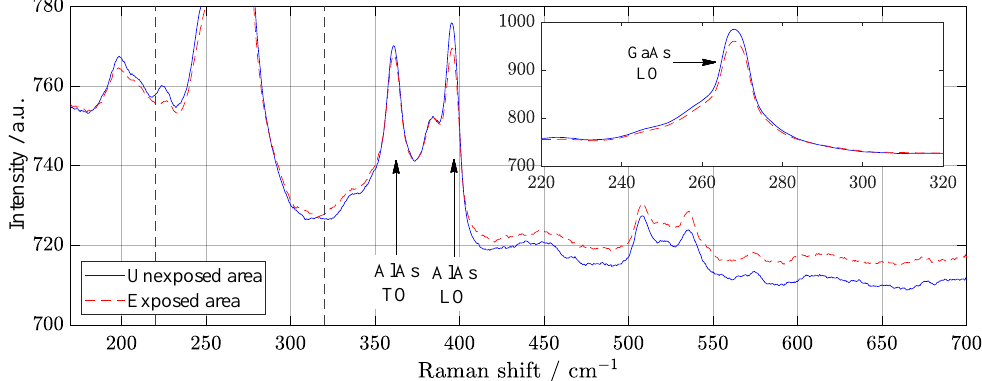
Figure 3. Raman spectroscopy from specimen processed by supercontinuum laser irradiation. Due to the height of the transverse-optical mode of GaAs, in order to preserve detail, the peak was plotted in a separate graph. Differences in relative intensities of AlAs phonons indicates possible displacements at As sites. Exposed area is measured after SL illumination of 67 days.